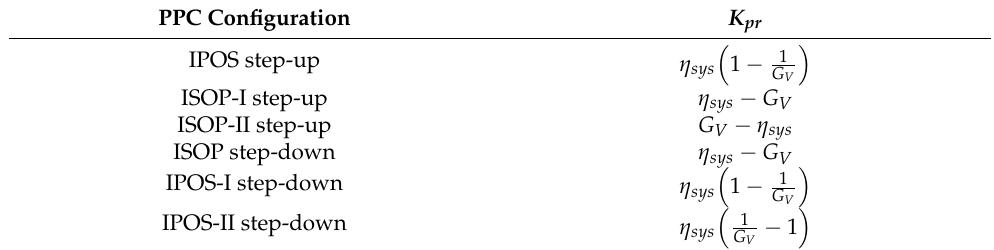
Table 2. K pr for different PPC configurations of Figure 10.